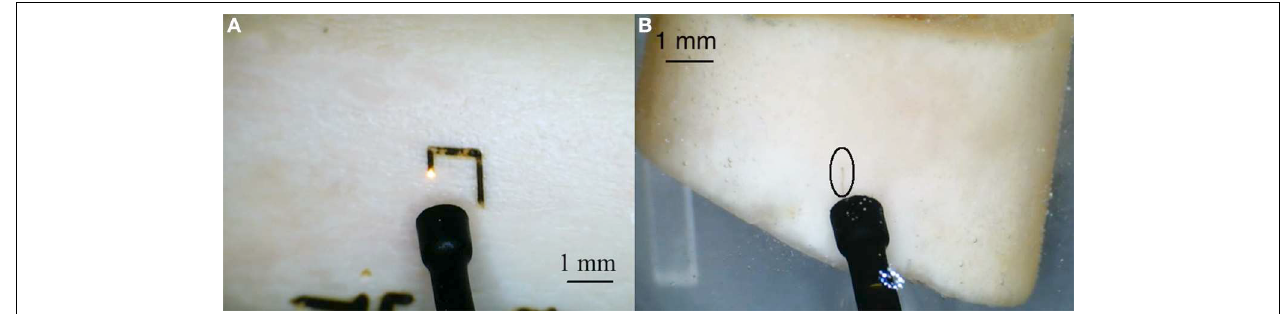
FIGURE 13 | Processing of bone with NCF delivered Er:YAG laser pulse4s (2.94 µ m 225 µ s) (A) in air and (B) under water (the black circle highlights the cut region) [51].